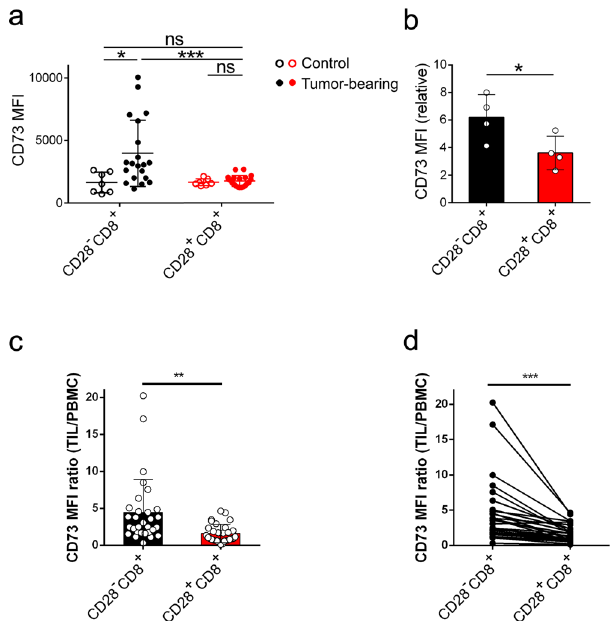
Fig. 5 CD28 expression on CD8 + T cells in the tumor